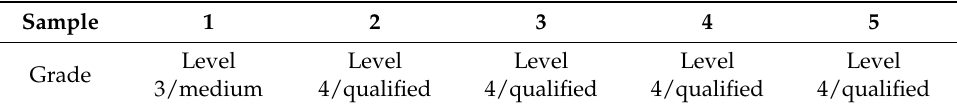
Table 9. The results of the power quality